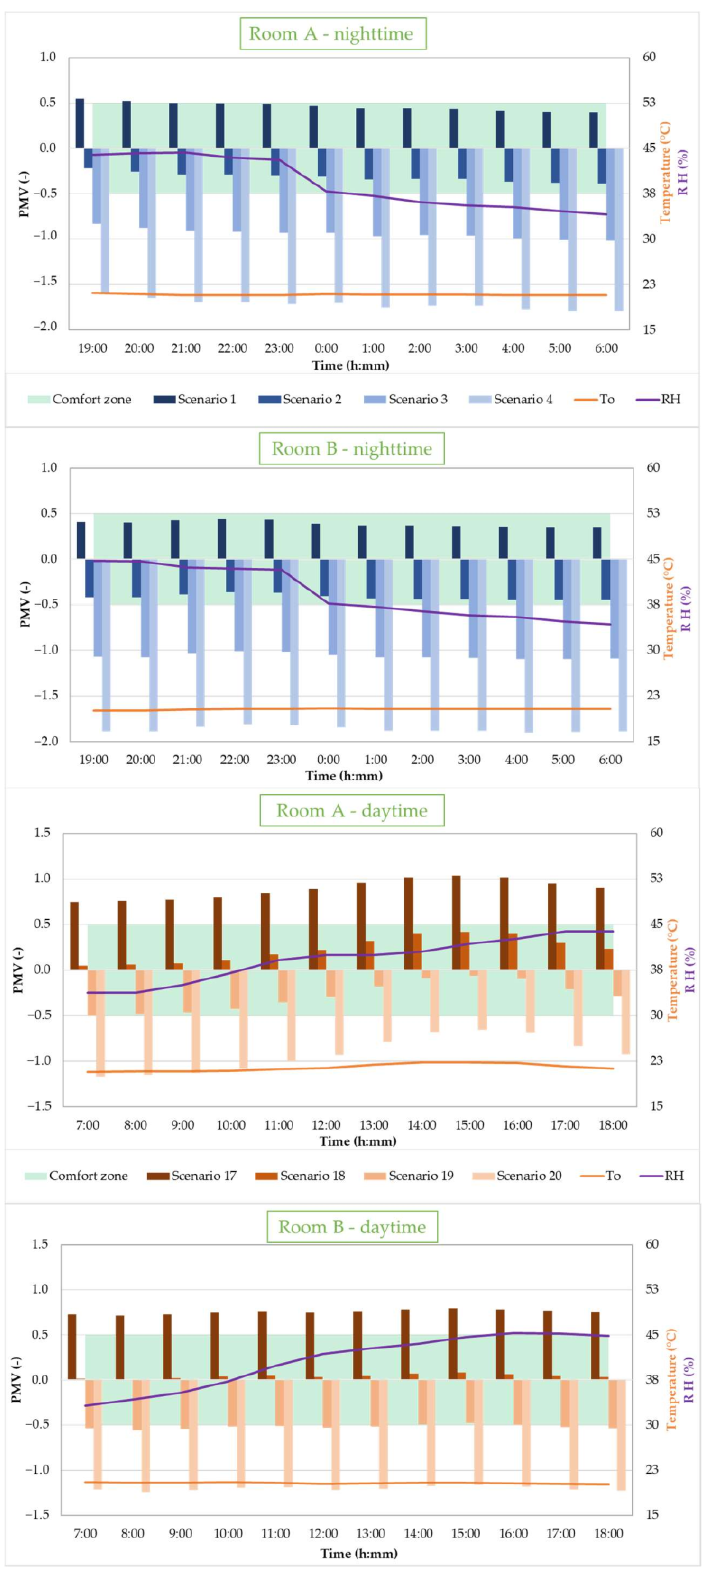
Figure 19. Hourly operative temperature, relative humidity, and PMV in rooms A and B with a bedridden patient: different scenarios in the winter